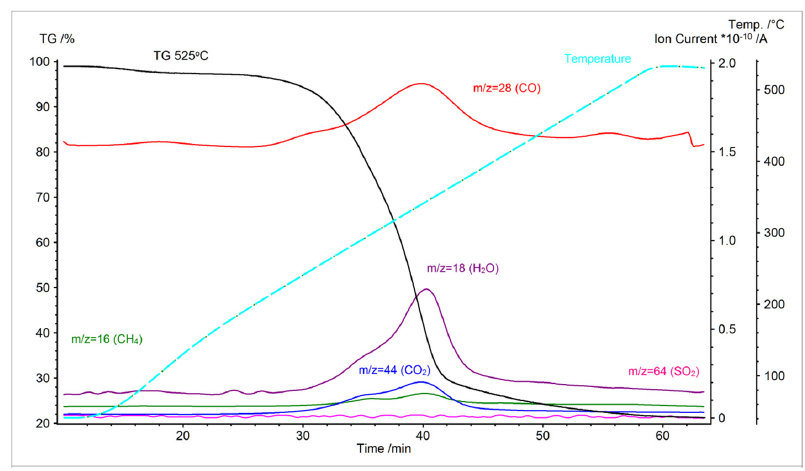
Figure 14. Thermogravimetric curve and ion current curves for Miscanthus thermochemical conversion performed at 525 °C.